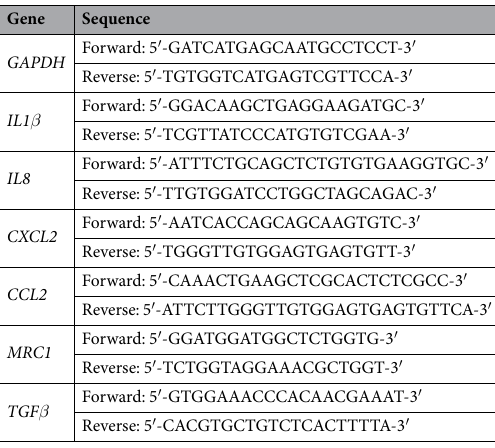
Table 1. Primers used for qPCR